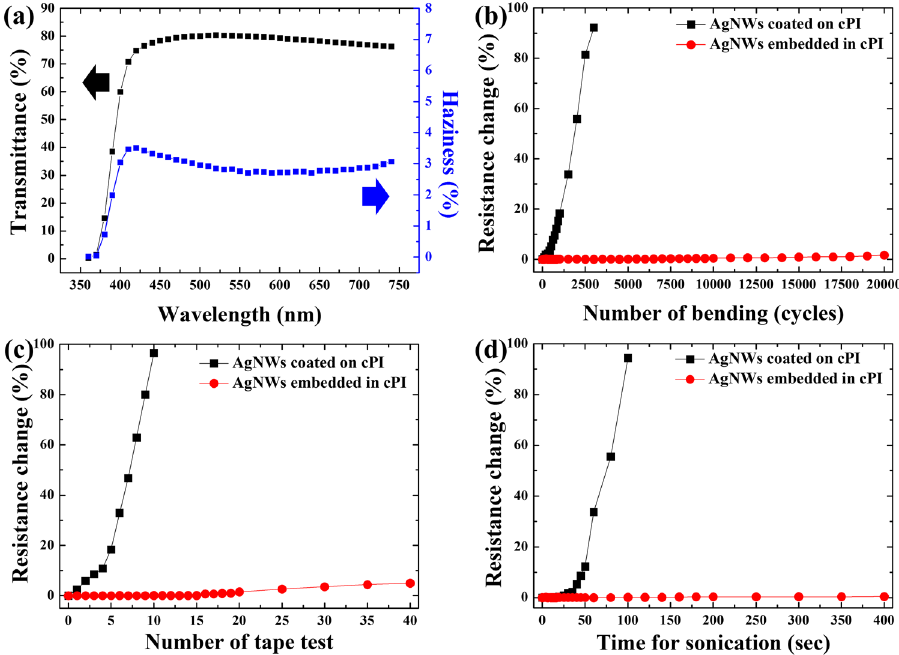
Figure 3. ( a ) Transmittance and haziness of the AgNWs/cPI electrode, ( b – d ) resistance change of the AgNWs/ cPI electrodes as a function of number of bending cycles, tape tests, and sonication time, respectively.